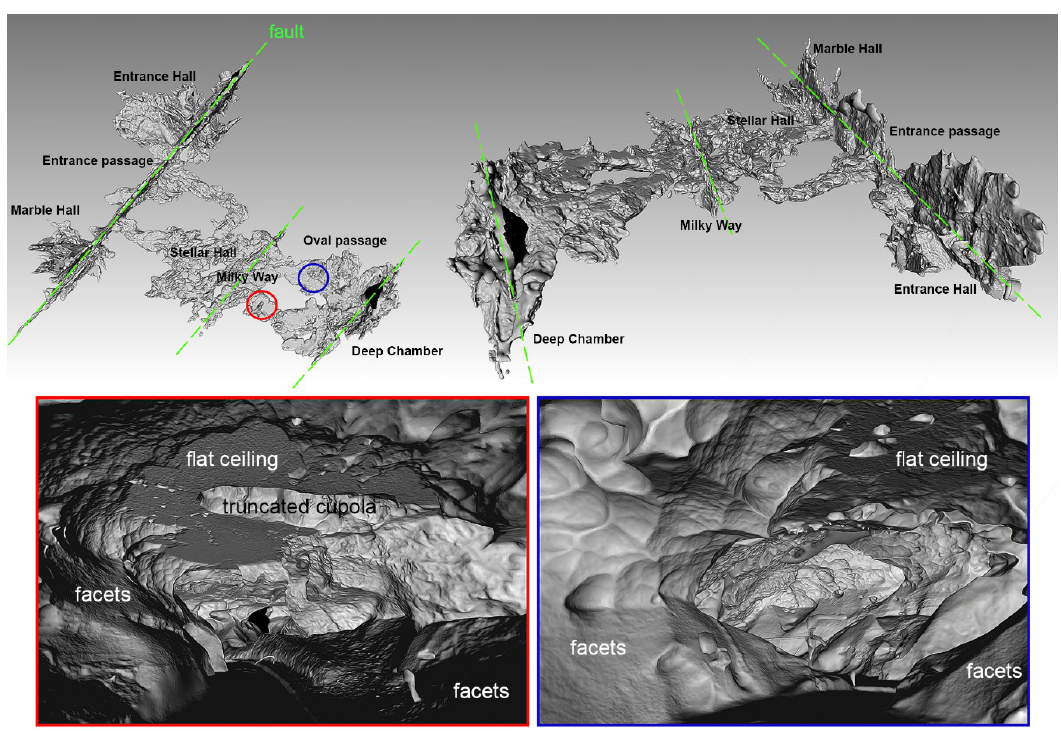
Figure 10. Up—top and isometric perspective view of the final 3D model; down—two inside views of the detailed 3D model created from the full resolution point cloud with characteristics features.